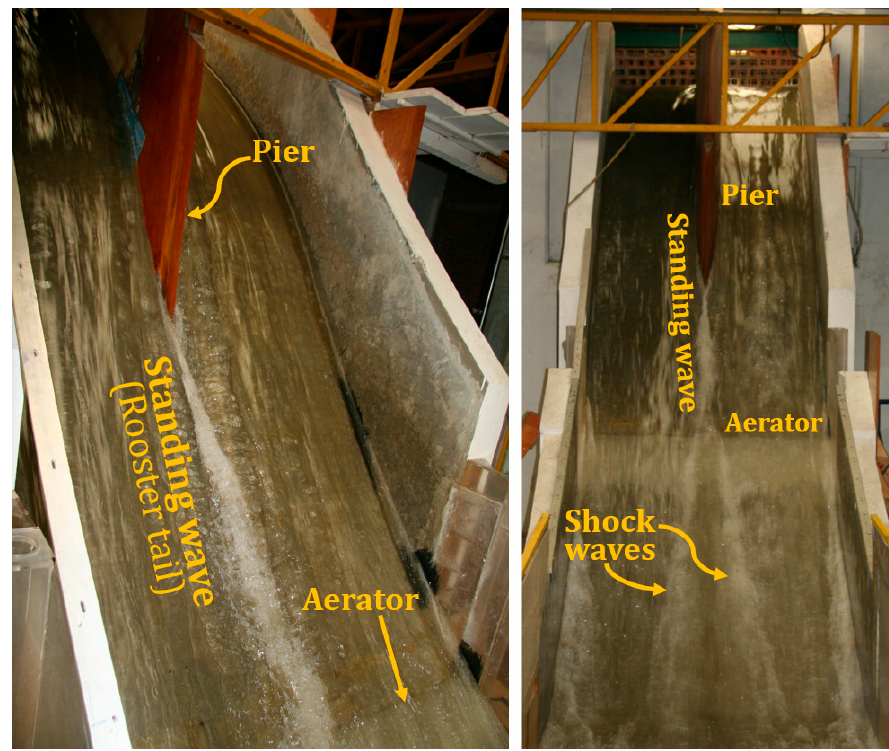
Figure 1. Standing and shock waves.